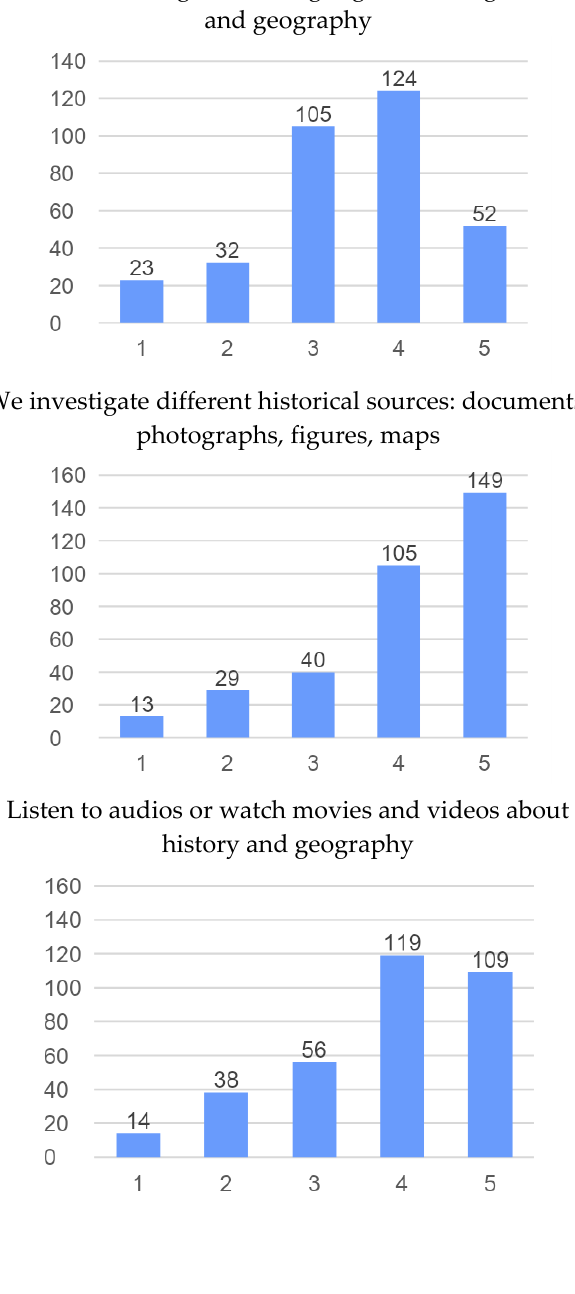
Figure 1. Usefulness of the social